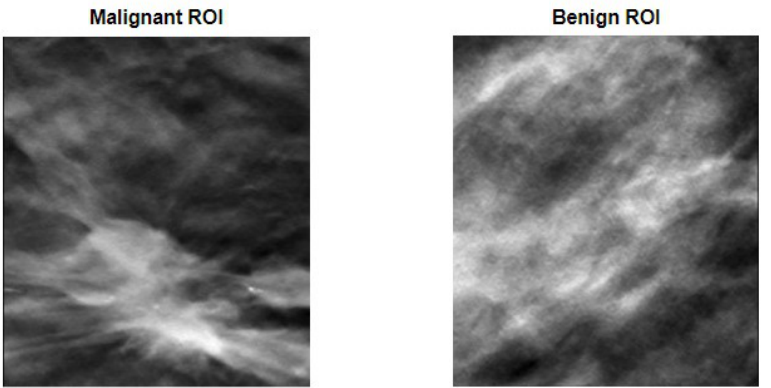
Figure 4. ROI definition to encapsulate malignant ( on the left ) and benign ( on the right ) lesions. After the image preparation, and given the sparse number of available images to train the model, data augmentation techniques that consisted of random rotation, translations, and mirroring were performed. Figure 5 compares the two previously shown original ROIs with a version of the said images after a random transformation.